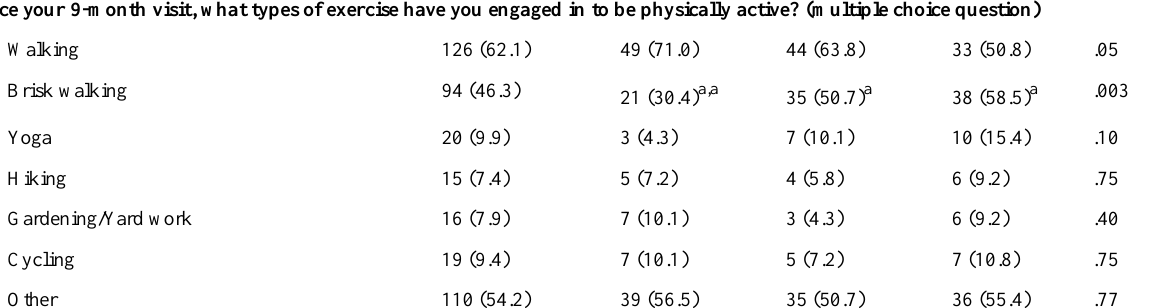
Overall P valuePlus